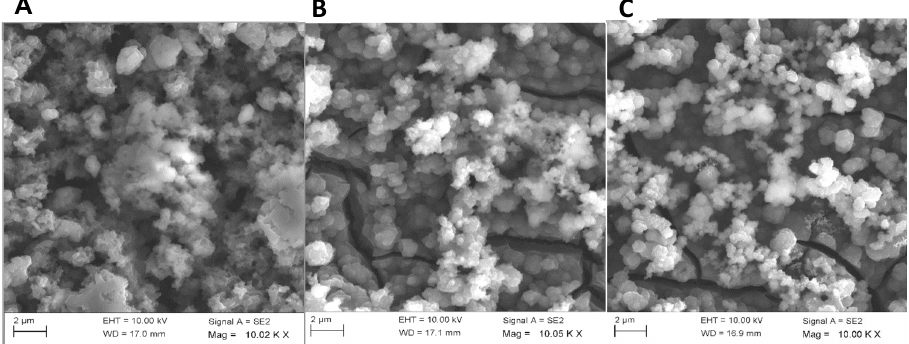
Figure 5. SEM images of ( A ) PDMA, ( B ) PDMA–PVS and ( C ) PDMA–PVS–Ag 0 nanocomposite. The HRTEM images in Figure 6 display a change from a polymer network morphol- ogy for PDMA–PVS (in Figure 6A) to a polymer network with well-dispersed spherical nanostructures (i.e., the black spheres in the images) for PDMA–PVS–Ag 0 nanocomposite (see Figure 6B and 6C). The HRTEM of PDMA–PVS–Ag 0, thus, suggests the intercalation of Ag 0 in the copolymer. The AFM image in Figure 7A indicates that the PDMA–PVS co- polymer network formed craters that have a wide range of sizes, indicating polydispersity